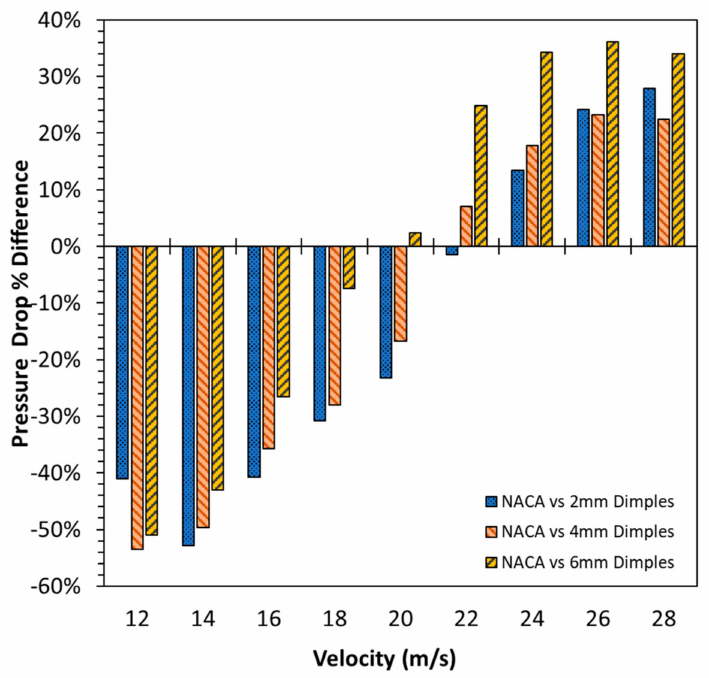
Figure 13. Pressure drop % difference for NACA fin vs. 2 mm-, 4 mm- and 6 mm-dimpled